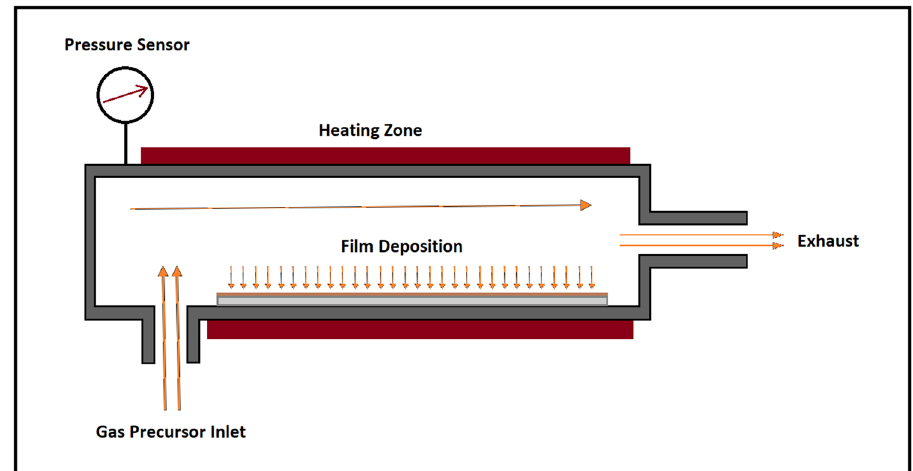
Figure 8: Schematic illustration of a chemical vapor deposition